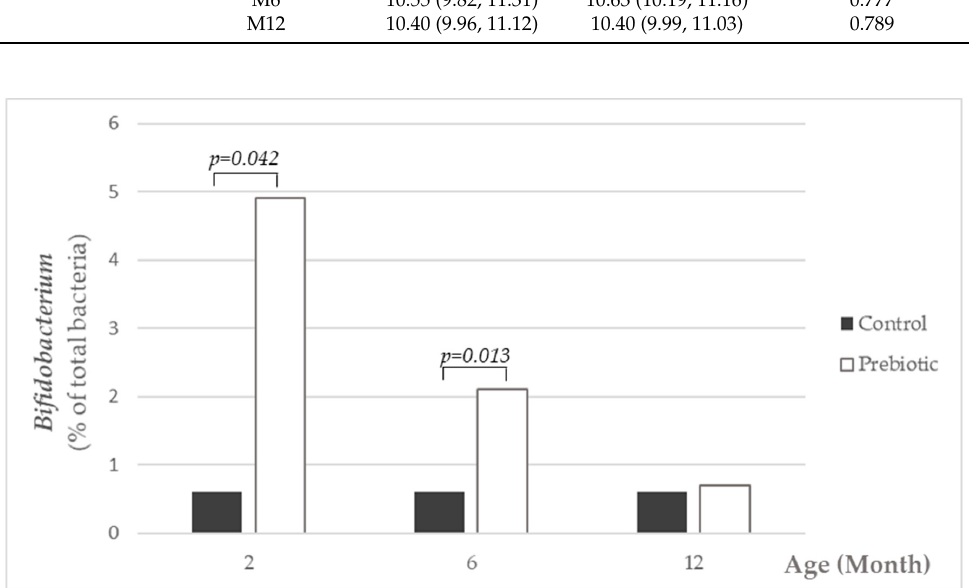
Figure 6. Fecal Bifidobacterium counts by group (median) of the percentage of total bacteria at months 2, 6 and 12. The black bars represent the control group, while the white bars indicate the prebiotic-supplemented group. Bifidobacterium counts were significantly higher in the prebiotic group at months 2 and 6 of age. Table 2. Fecal microbiota counts by group (median (IQR) of log cfu/g feces and statistical compari- son of prebiotic vs. control group at months 2, 6 and 12).